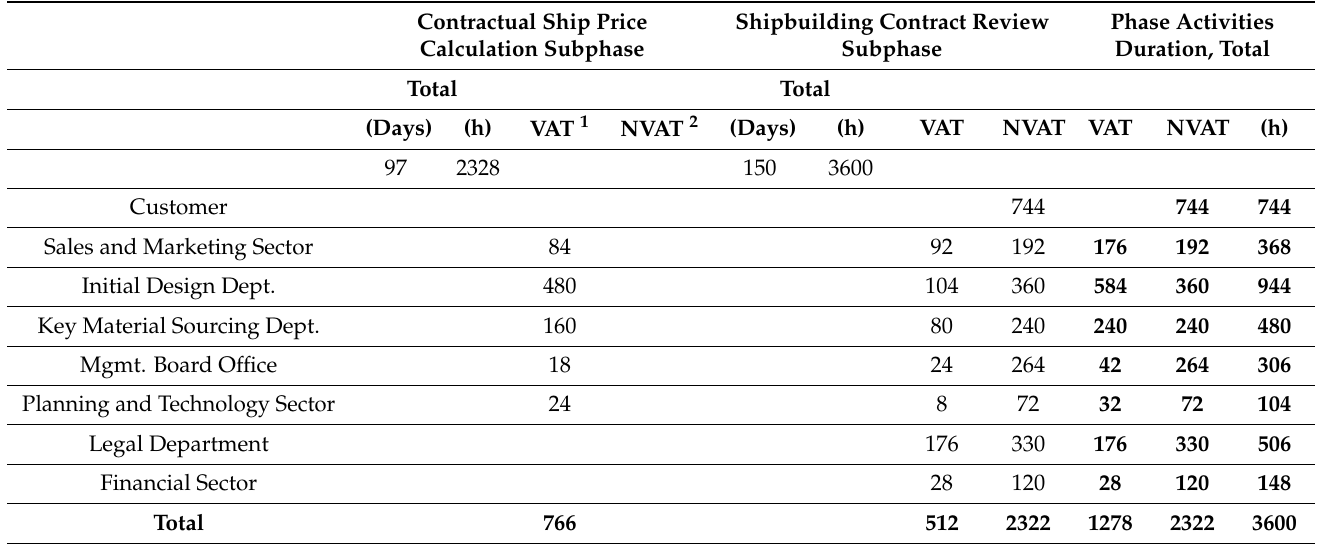
Table A5. The average durations of the contracting phase activities—the current state.